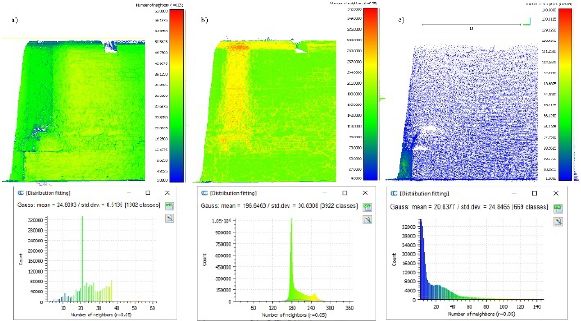
Figure 8. Density analysis (radius 5 cm). left) optimized Lidar data; middle) close-range photogr. data; right) SLAM data.